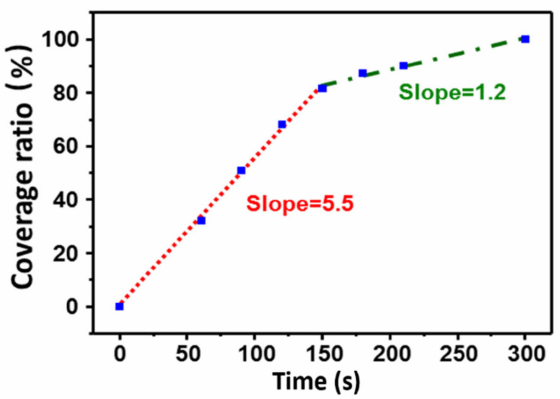
Figure 2. Coverage ratio (%) as a function of the immersion time for formation of complete PDA